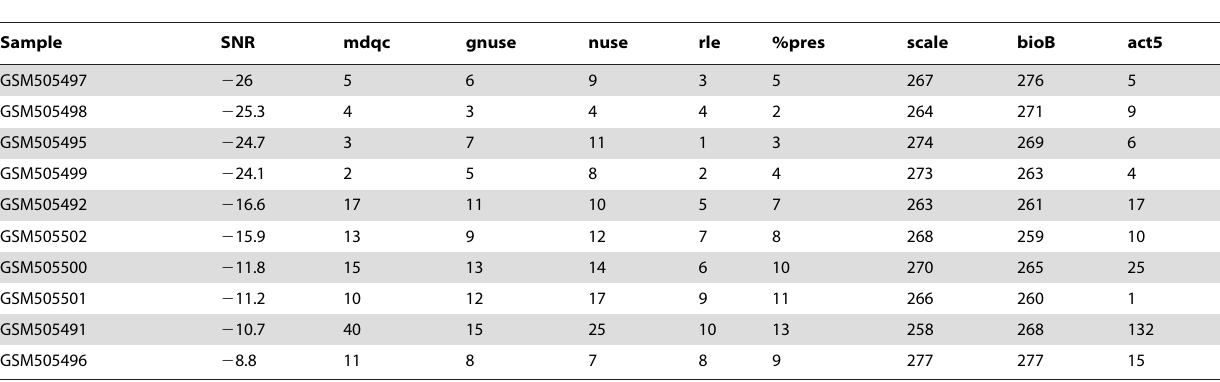
Table 1. Comparison of SNAGEE, MDQC, GNUSE and sample quality metrics on the breast cancer study from MAQC-II.